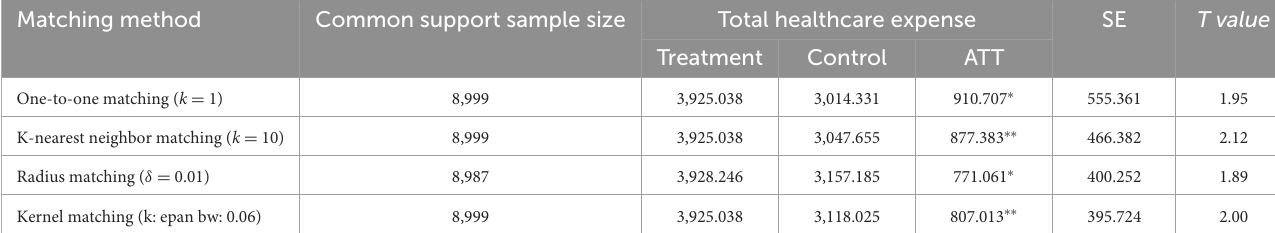
TABLE 3 The impact of MFA on healthcare expenses.